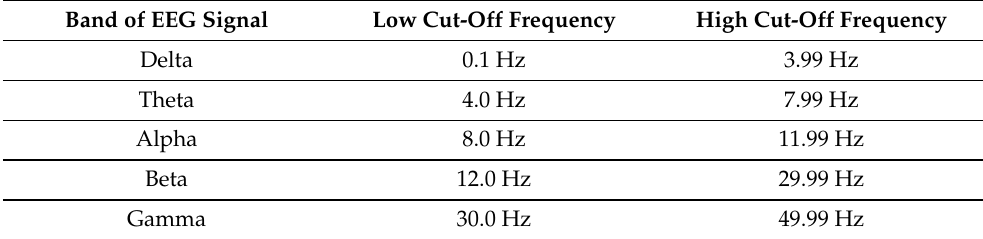
Table 2. Cut-off frequencies of bandpass filters for band extraction of EEG signals.